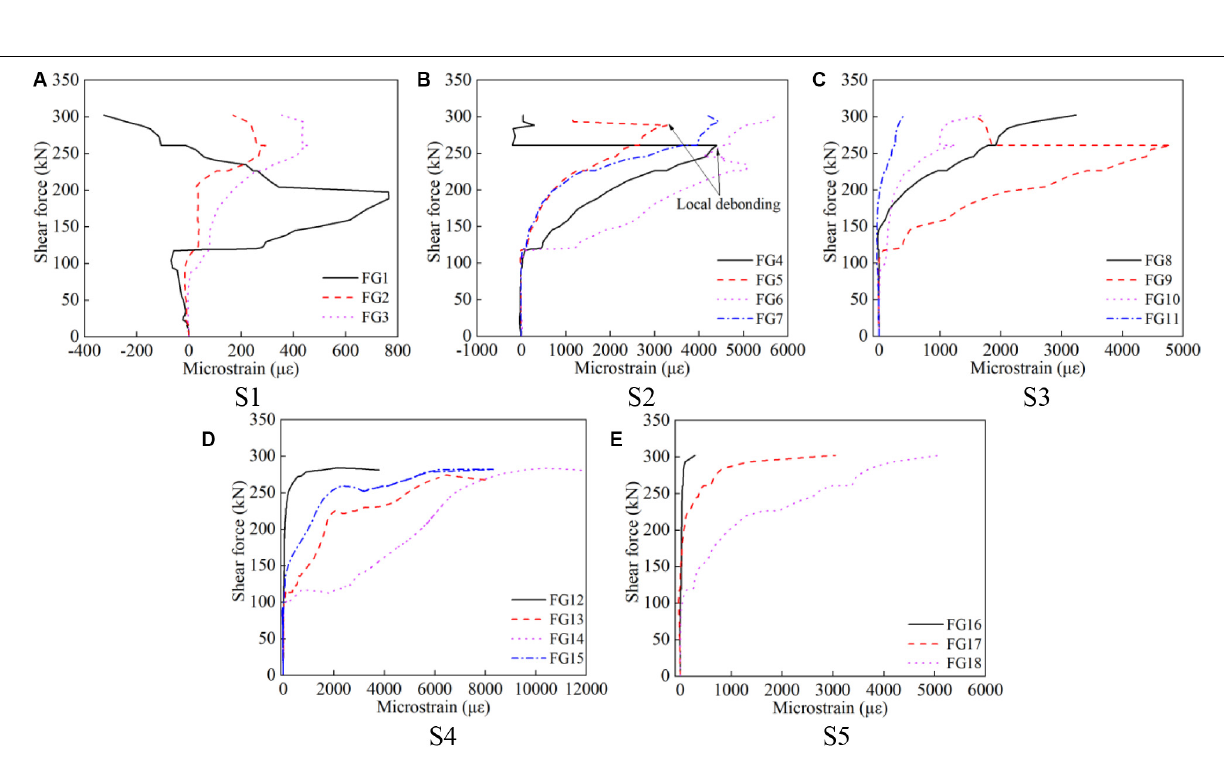
Frontiers in Materials |